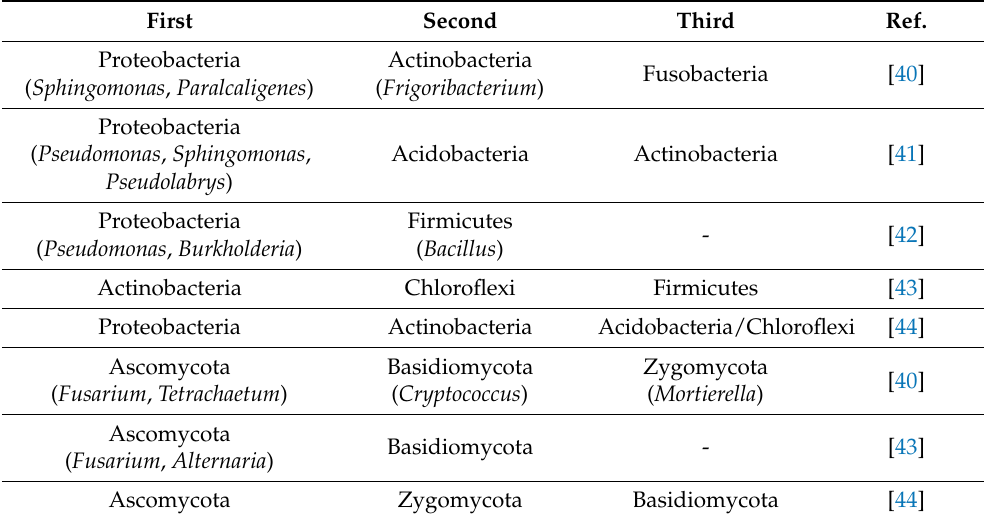
Table 2. Examples of studies of bacterial and fungal rhizobiome diversity in P. ginseng . The first most dominant phylum followed by the second and third most dominant phyla are listed with common genera within each phylum in parentheses when mentioned.